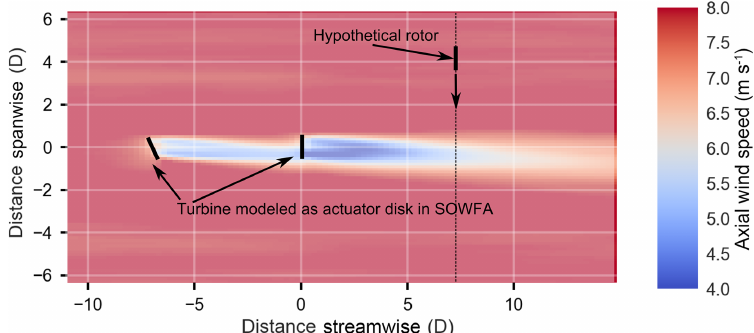
Figure 5. Layout of SOWFA simulation as in Fig. 1, now with two turbines. Note that only the first turbine is yawed in controlled cases.